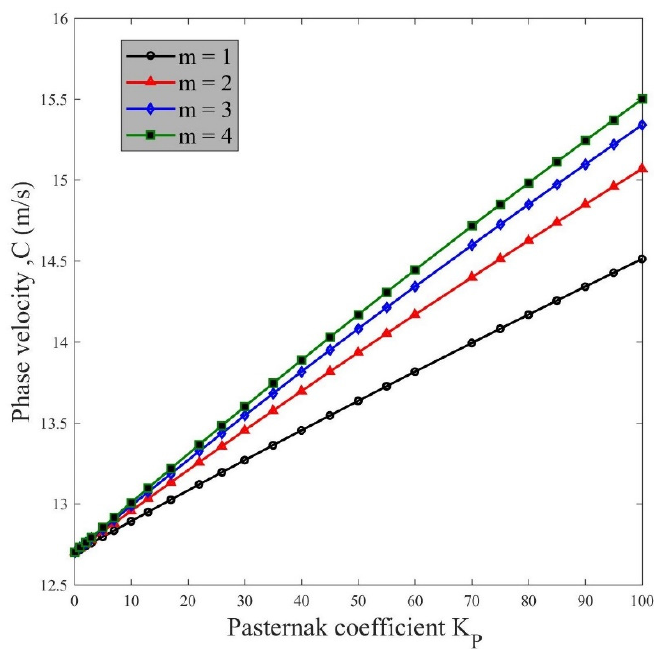
Figure 9. Phase velocity vs. Pasternak parameter for different m .